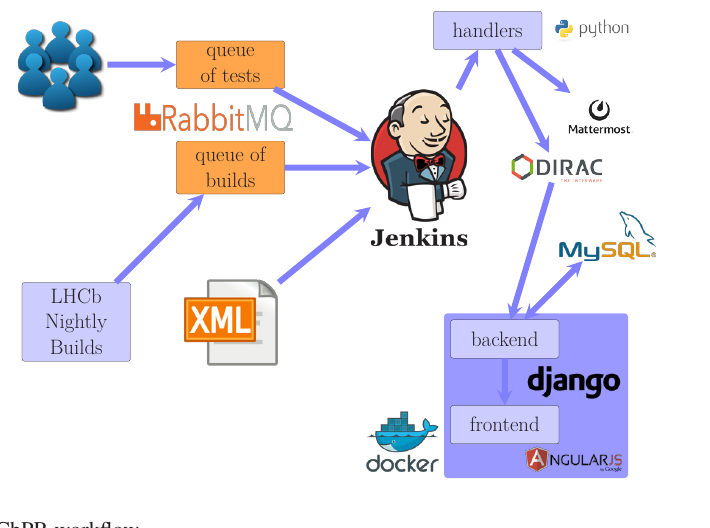
Figure 1. LHCbPR